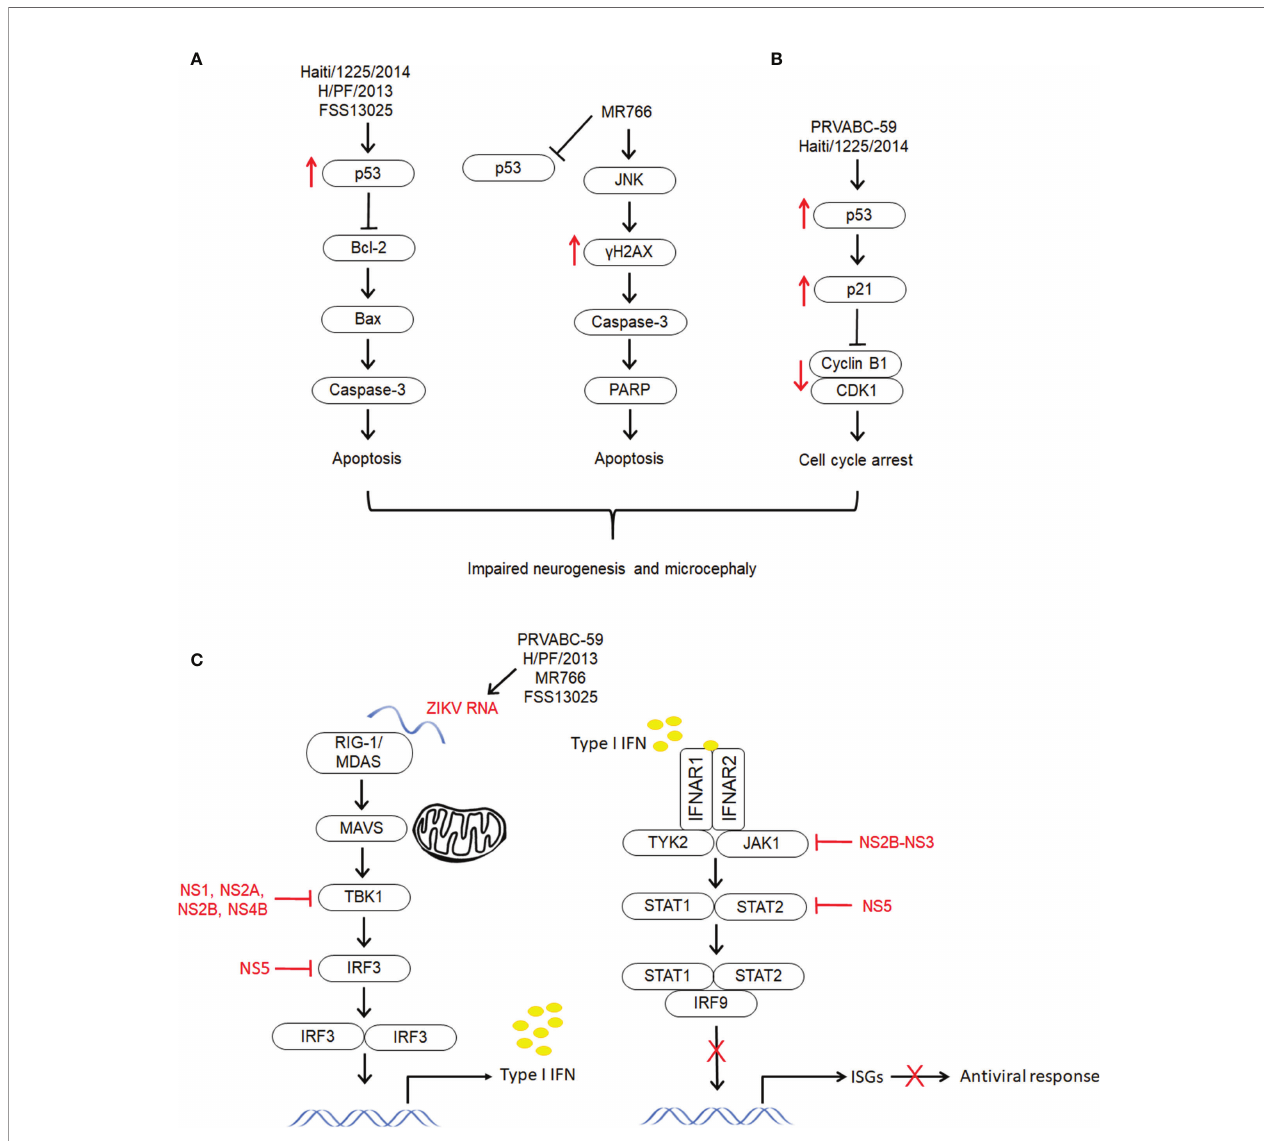
FIGURE 3 | The different mechanisms exploited by different strains of ZIKV to establish infection and develop neuropathogenesis. The molecular mechanisms underlying ZIKV infection and neuropathogenesis have shown to be lineage speci fi c. (A) Apoptosis. Both Asian lineage strains (HAITI/1225/2014, H/PF/2013 and FSS13025) and African lineage strain (MR766) induce apoptosis via activation of caspase-3. However, only the Asian strains showed upregulation of p53 and they have shown to induce intrinsic cell death pathway through regulation of Bcl-2 (114 – 116). On the other hand, the apoptosis induced by the African strain could be via JNK pathway through activation of g H2AX (115, 117, 118). (B) Cell cycle arrest. Unlike other Asian lineage strains PRVABC59 and HAITI/1225/2014 showed induction of cell cycle arrest through upregulation of p53 and p21Cip1/Waf1, and downregulation of cyclin B1 and cell cycle kinase CDK1 (114, 115). (C) Immune response. Zika virus infection has demonstrated to activate type II IFN, and supress type I and type II IFN signaling. This differential modulation of IFN signaling which is associated to destabilization of STAT2 has resulted in selective expression of ISGs and differentiated activation of immune and proin fl ammatory response (119). Zika virus structural proteins (NS5, NS2A, NS2B, NS4B, NS4A and NS2B-NS3) have demonstrated to modulate immune response through distinct pathways (119 –